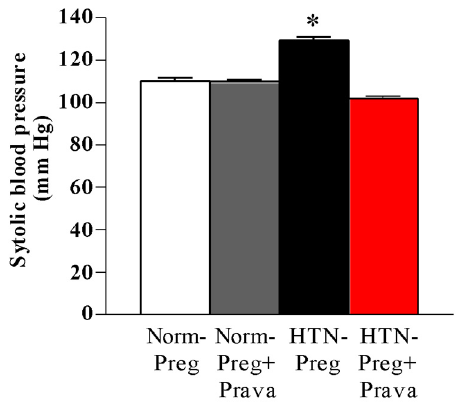
Figure 1. Systolic blood pressure measured in Norm-Preg, Norm-Preg + Prava, HTN-Preg, and HTN-Preg + Prava groups. Values represent mean ± SEM. * p < 0.05 vs. Norm-Preg group.